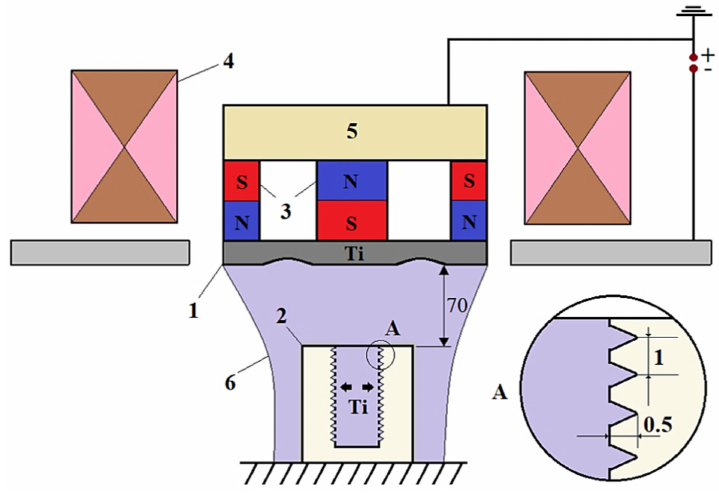
Figure 2. Scheme of magnetron sputtering: 1—sputtering cathode; 2—ceramic sample; 3—permanent magnets; 4—electromagnet; 5—magnetic circuit; 6—sputtered titanium.